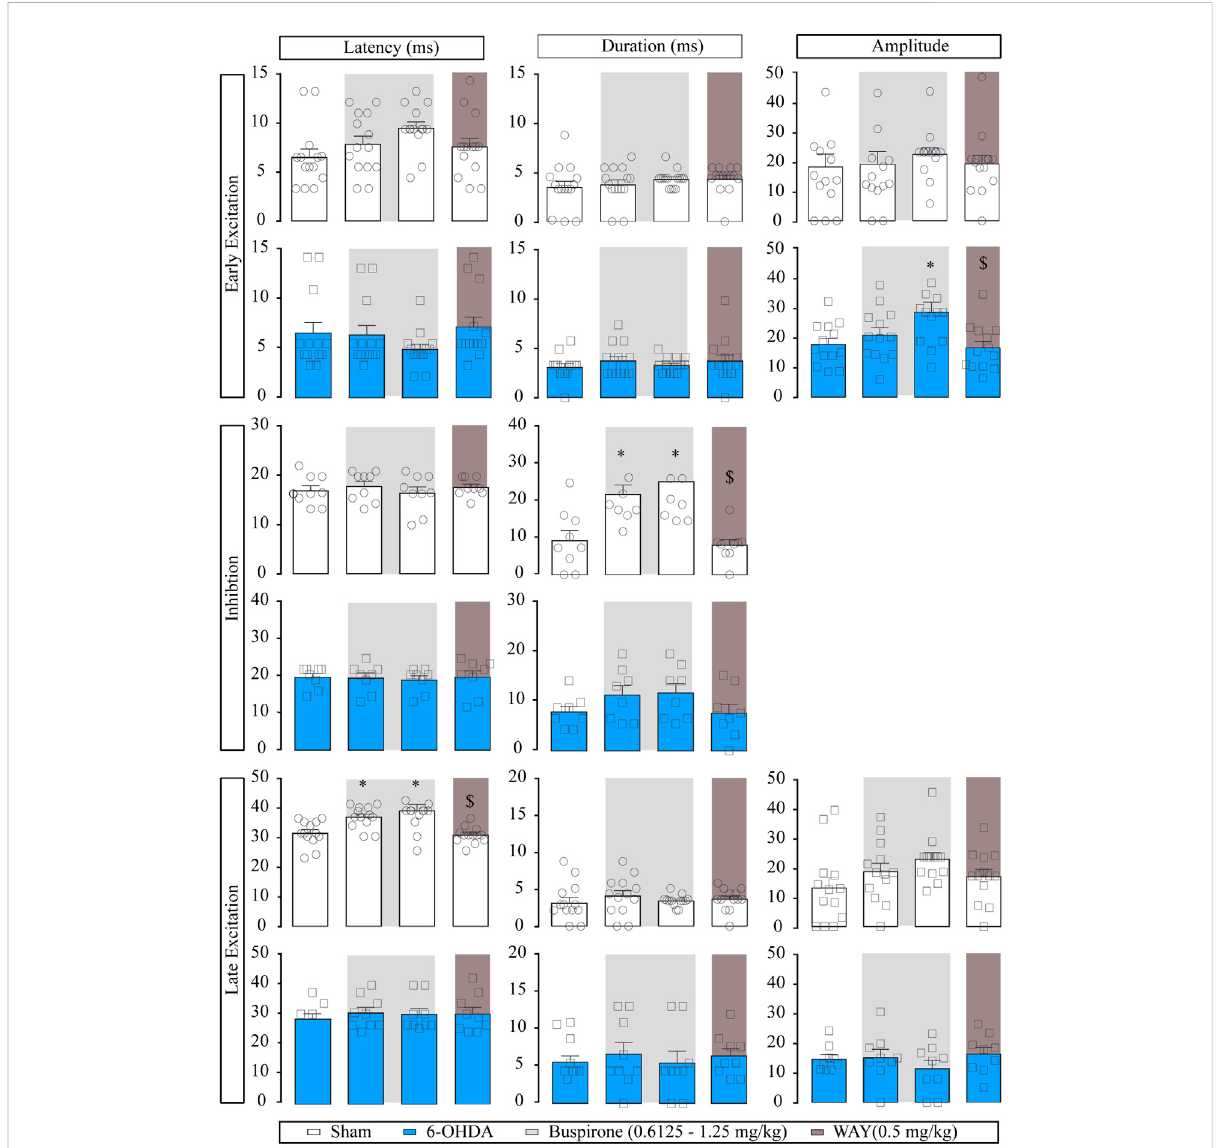
FIGURE 3 Effect of the systemic administration of buspirone on motor cortico-nigral information. Representation of characteristic parameters related to cortically evoked responses (latency, duration, and amplitude of the responses). The latency, duration, and amplitude of the early excitatory component are on the top (sham n = 11, 6-OHDA n = 13). The latency and duration of the inhibitory component are in the middle (sham n = 7, 6- OHDA n =8).Thelatency,duration,andamplitude ofthelateexcitatorycomponent areonthebottom(sham n =10,6-OHDA n =9).Notethat buspirone enhanced the duration of inhibition in the sham group and delayed the latency of late excitation. Each bar represents the mean ± S.E.M. Eachdotrepresentsthevaluefromoneneuronbeforeandafterbuspirone(0.6125and1.25 mg/kg,i.v.)inlightgreyandWAY-100635(0.5 mg/kgi.v.) in dark grey. * p < 0.05 vs. respective baseline; and $ p < 0.05 vs. buspirone (RM two-way ANOVA followed by Bonferroni ’ s post hoc